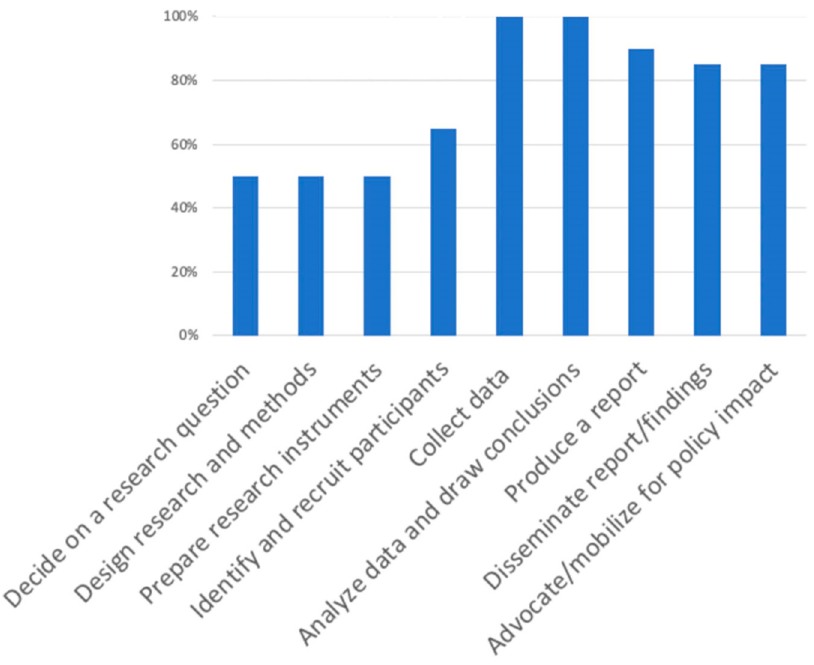
Figure 4. Proportion of participatory processes in which youth were directly engaged.